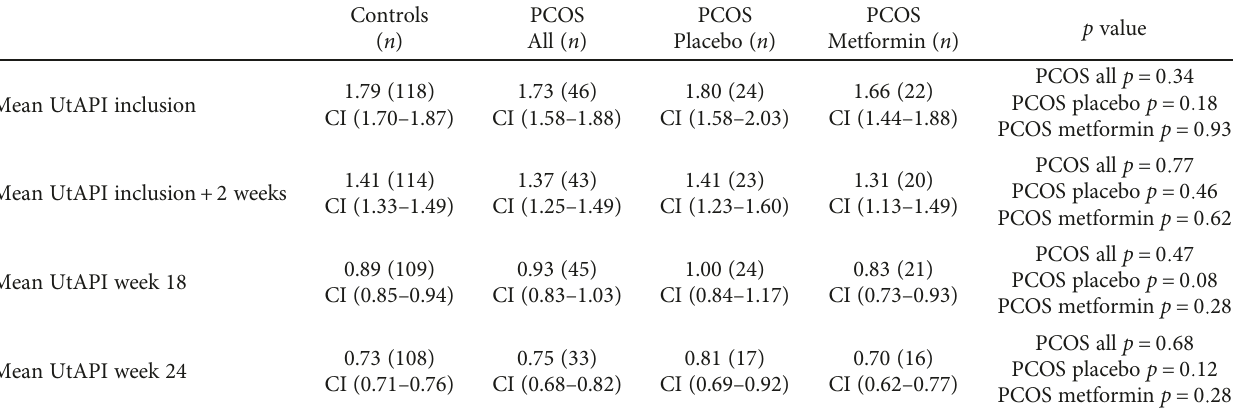
Table 3: Mean UtAPI values and number of examinations at each given study point. In the analysis, we adjusted for gestational age. Controls